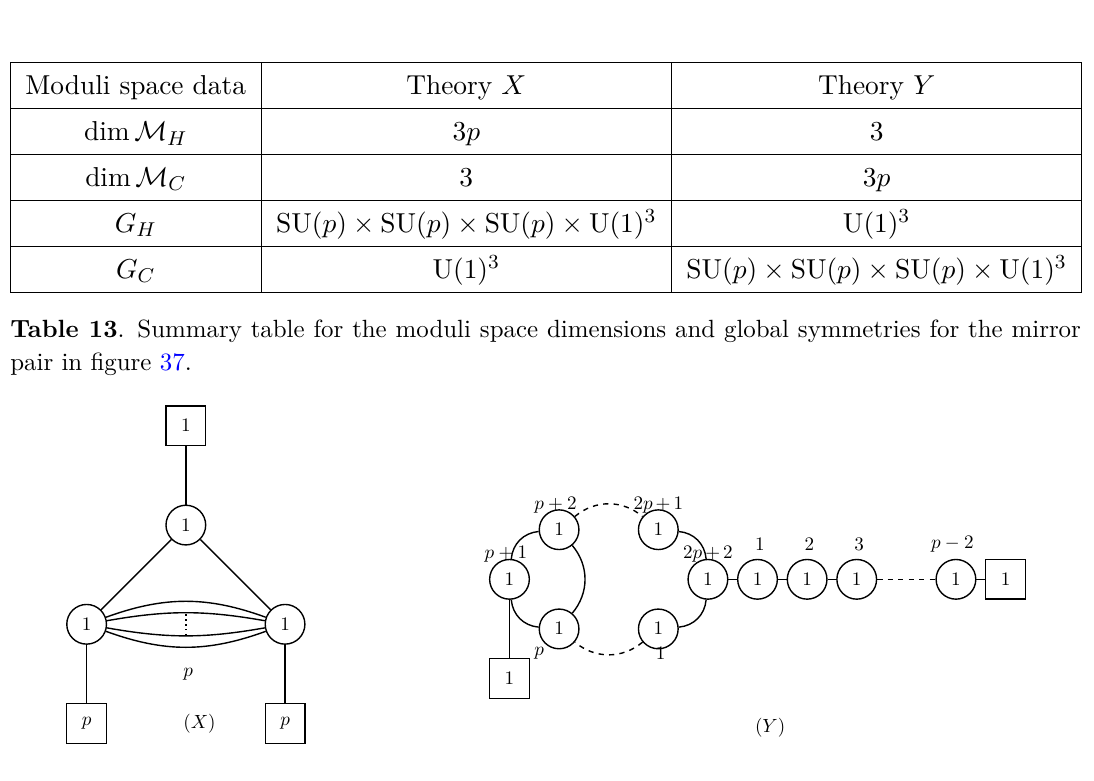
Figure 37 . The pair of Lagrangian theories associated with the 3d N = 4 SCFT that arise from the dimensional reduction of an ( A ) AD theory on a circle, for s = 2 and generic p . s , D ( s +1) p +2 Quiver ( X ) was obtained using class S construction of AD theories, while quiver ( Y ) is the proposed 3d mirror dual of quiver ( X )